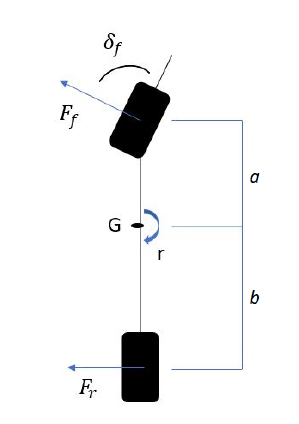
Figure 5. Single track vehicle